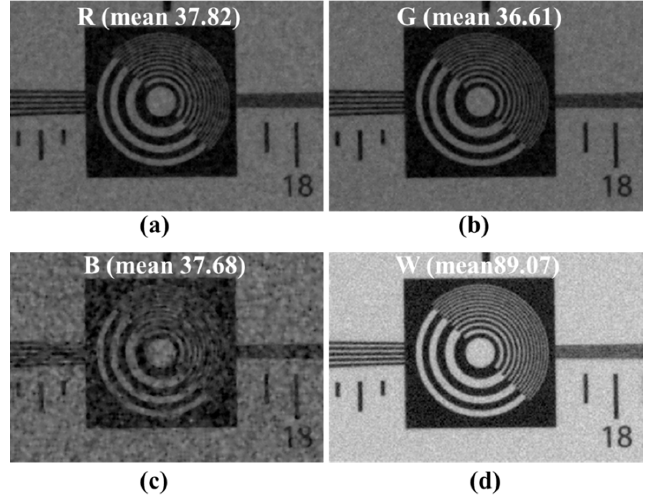
Figure 2. Demosaicing result [24] of the RGBW CFA; ( a ) red (R) channel; ( b ) green (G) channel; ( c ) blue (B) channel; ( d ) white (W) channel.